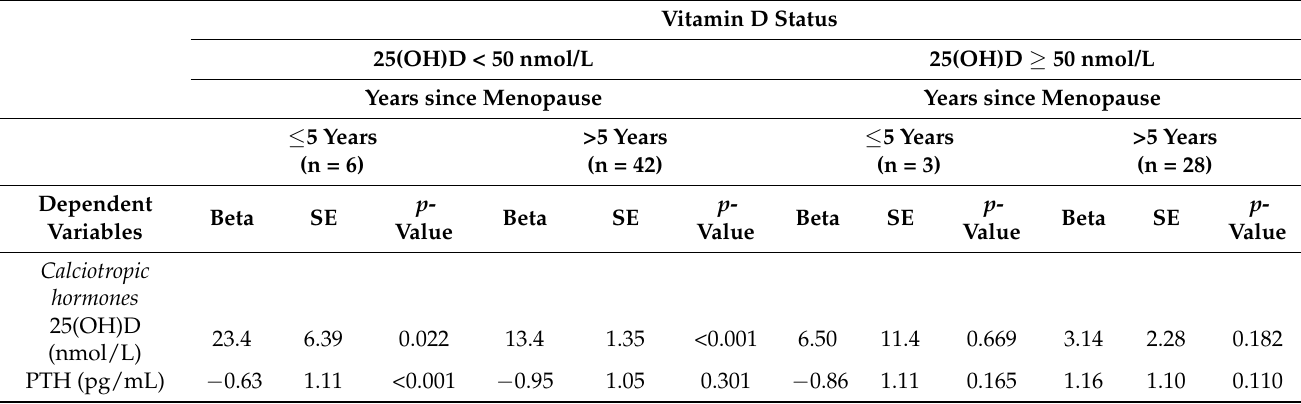
Table 3. Effect of the intervention with vitamin D-enriched cheese compared with the control group (independent variable) on serum concentrations of calciotropic hormones and bone resorption markers at follow-up (dependent variables), by vitamin D status at baseline and years since